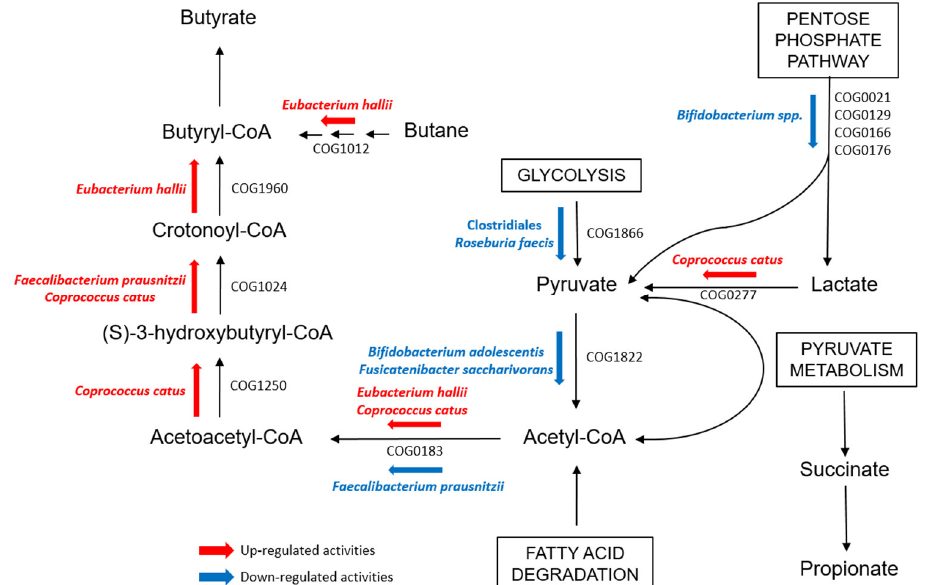
Figure 4. Scheme evidencing the detected up- and down-regulated bacterial functions involved in the butyrate pathway through Acetyl-CoA in the GM of T1D children when compared with that of healthy CTRL.